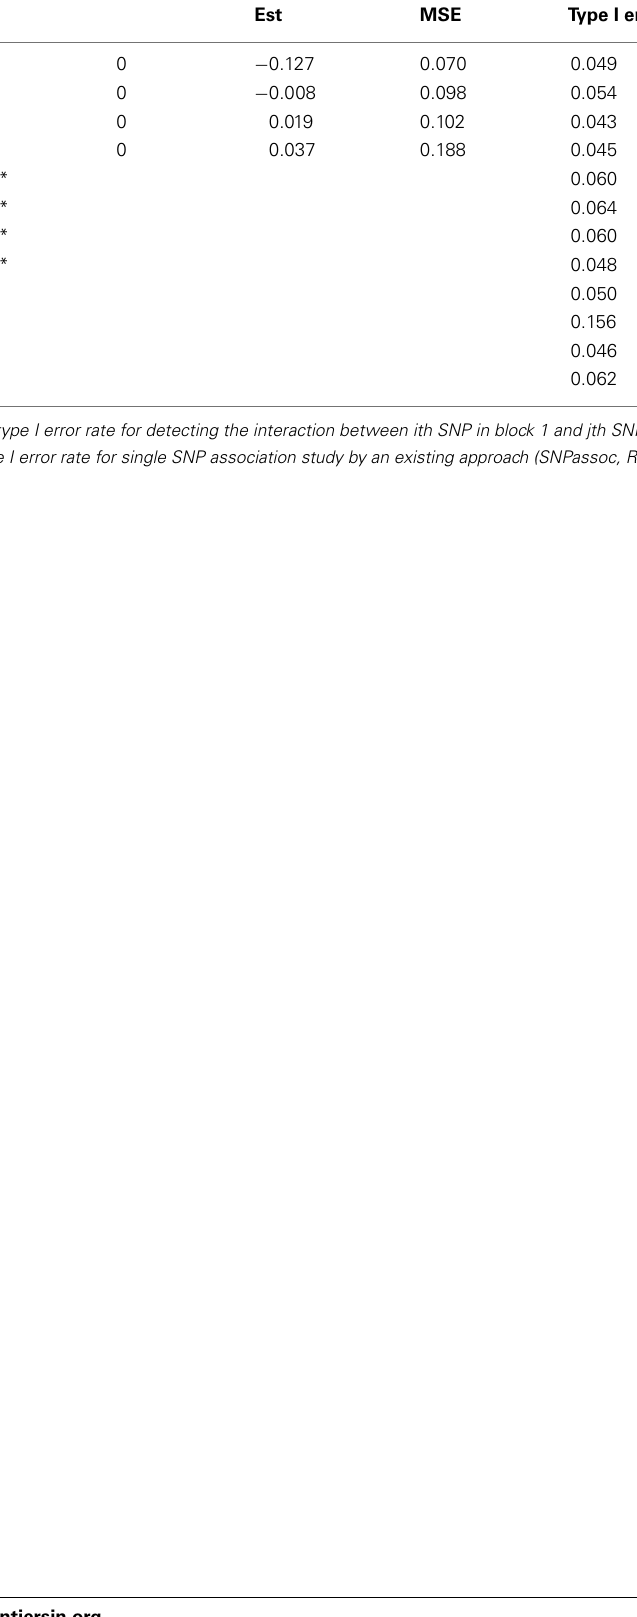
TableA5 |Type I error rate for all epistatic detection of two independent blocks under Scenario 3 for 1000 simulations.